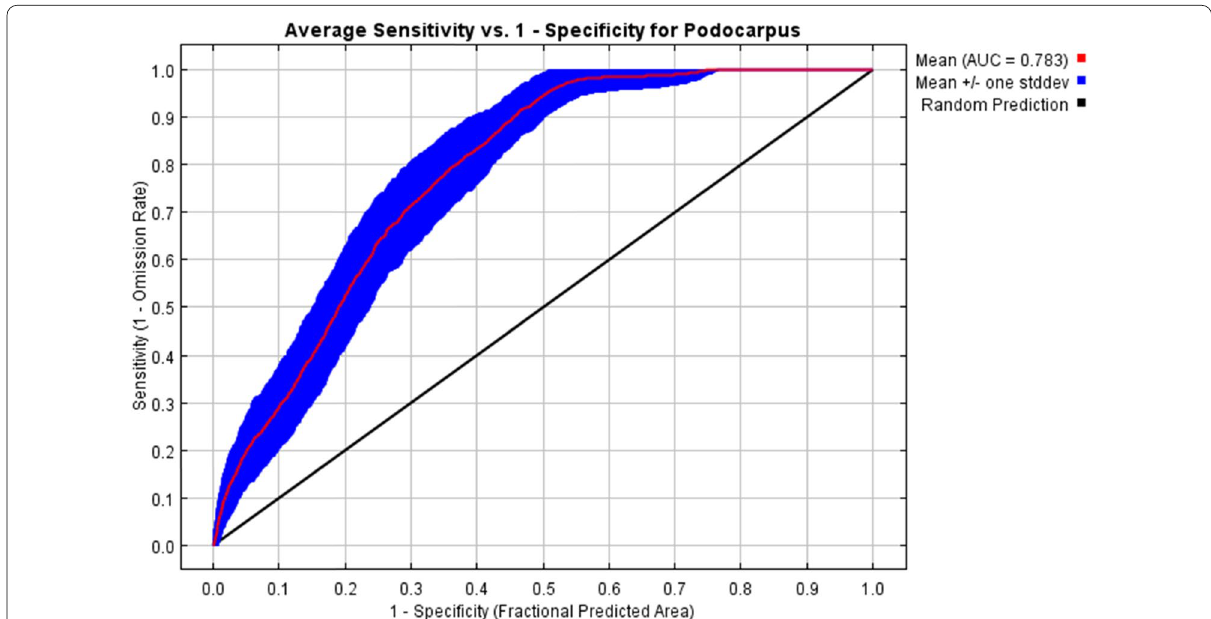
Fig. 3 Sensitivity versus 1-specificity for P. falcatus averaging 100 replicate